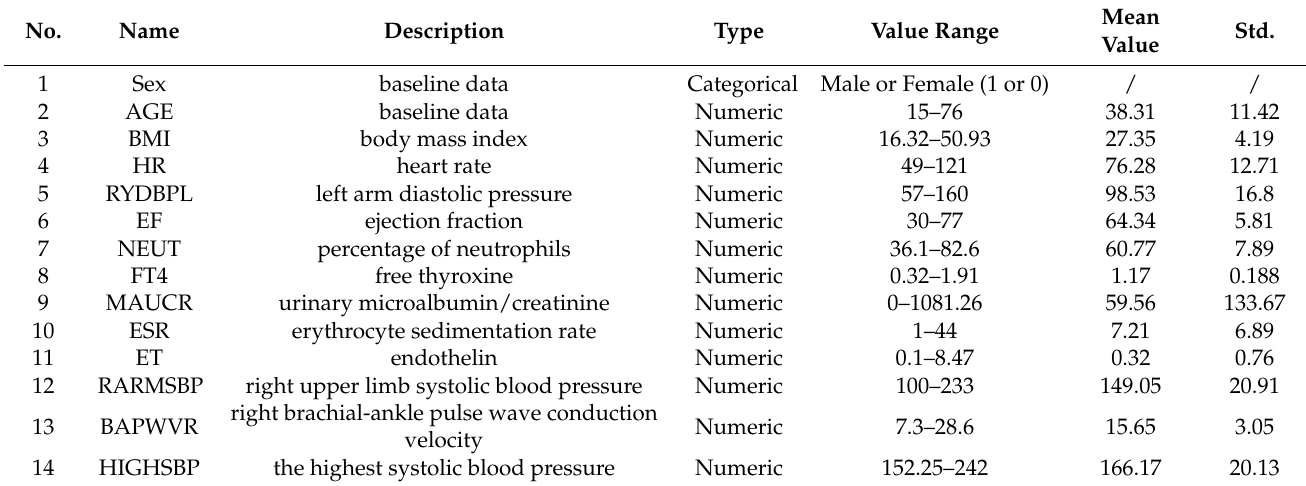
Table 1. Description of partial hypertension examination